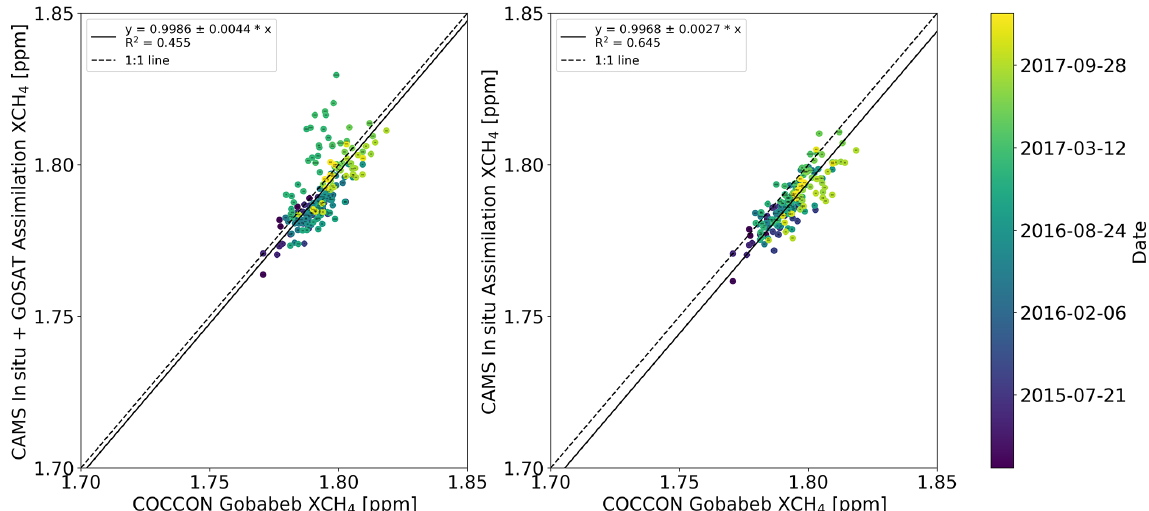
Figure 16. XCH 4 correlation plots between coincident COCCON Gobabeb observations and CAMS model data. The left panel shows the model data assimilated with in situ and GOSAT data; the right panel shows the in situ assimilated model data. Error bars denote the 1 σ standard deviation of the hourly mean values for COCCON